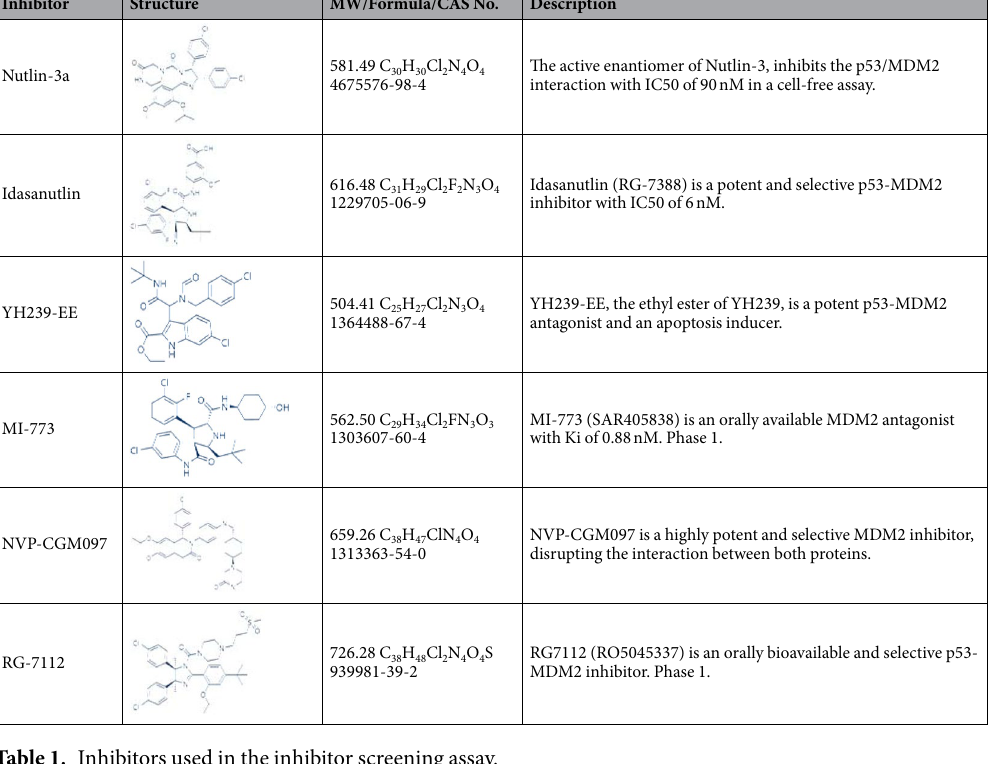
Table 1. Inhibitors used in the inhibitor screening